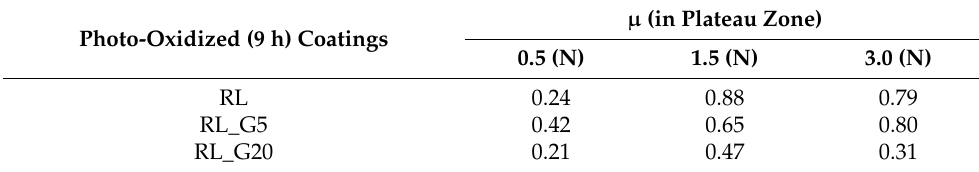
Table 5. Coefficient of friction values for photo-oxidized